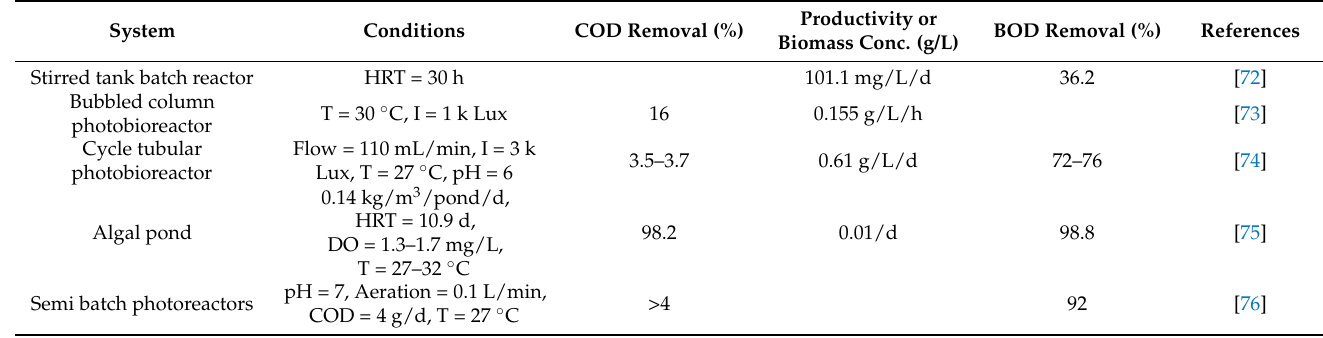
Table 3. Distillery effluent treatment using various reactor types in the presence of microalgae.